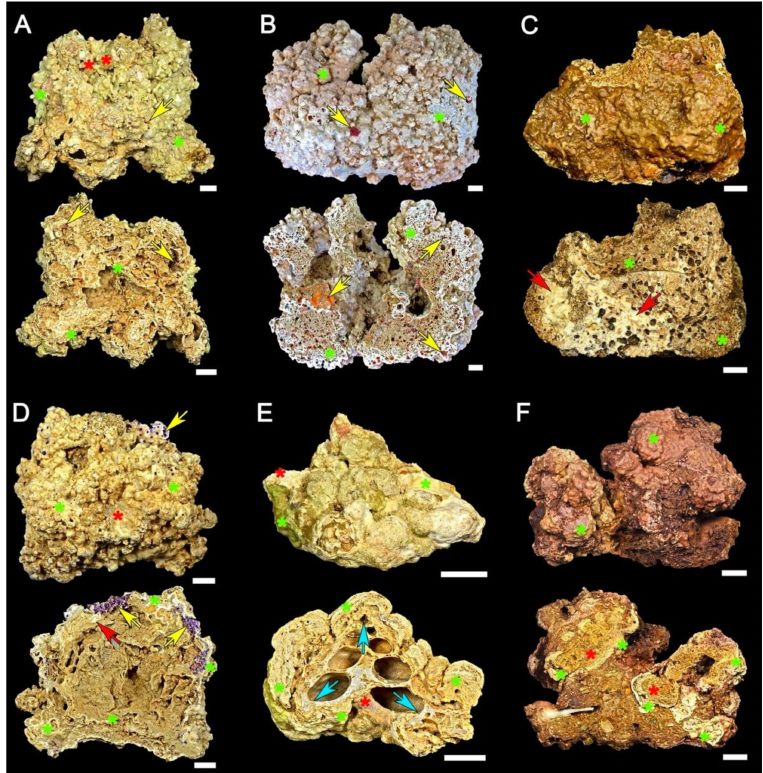
Figure 4. Surface and inner portion of rhodoliths analyzed in this study (upper and lower images, respectively): North sector: ( A ) rhodolith from site 1; ( B ) rhodolith from site 2; Central sector: ( C ) rhodolith from site 3; South sector: ( D ) rhodolith from site 5; ( E ) rhodolith from site 6; ( F ) rhodolith from site 7. Non-geniculate coralline algae (green asterisks), bryozoan (red asterisks), coral (red arrows), sponge Cliona cf. schmidtii (yellow arrows), gastropod (blue arrows). Scale bars = 1 cm.